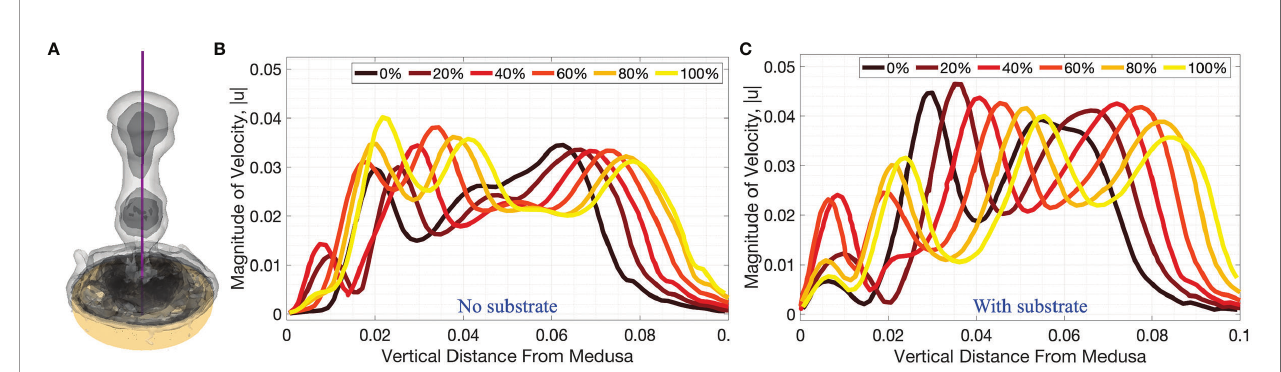
FIGURE 10 | 3D velocity magnitude (in units of m s -1 ) along the vertical centerline through the middle of the numerical bell, as depicted in (A) , for cases when (B) no substrate is present and (C) the bell is resting against the substrate throughout the fourth pulsation cycle (vertical distance in units of m). Centerline velocities are shown during the fourth pulsation cycle at 0%, 20%, 40%, 60%, 80%, and 100% of drawn towards the top of the bell and then moves around the sides of the bell and into the wake. The presence of the substrate effectively acts as a wall, and fl uid must be drawn towards the jelly fi sh along this surface. The potential bene fi ts or consequences of this set up are not immediately clear. Our